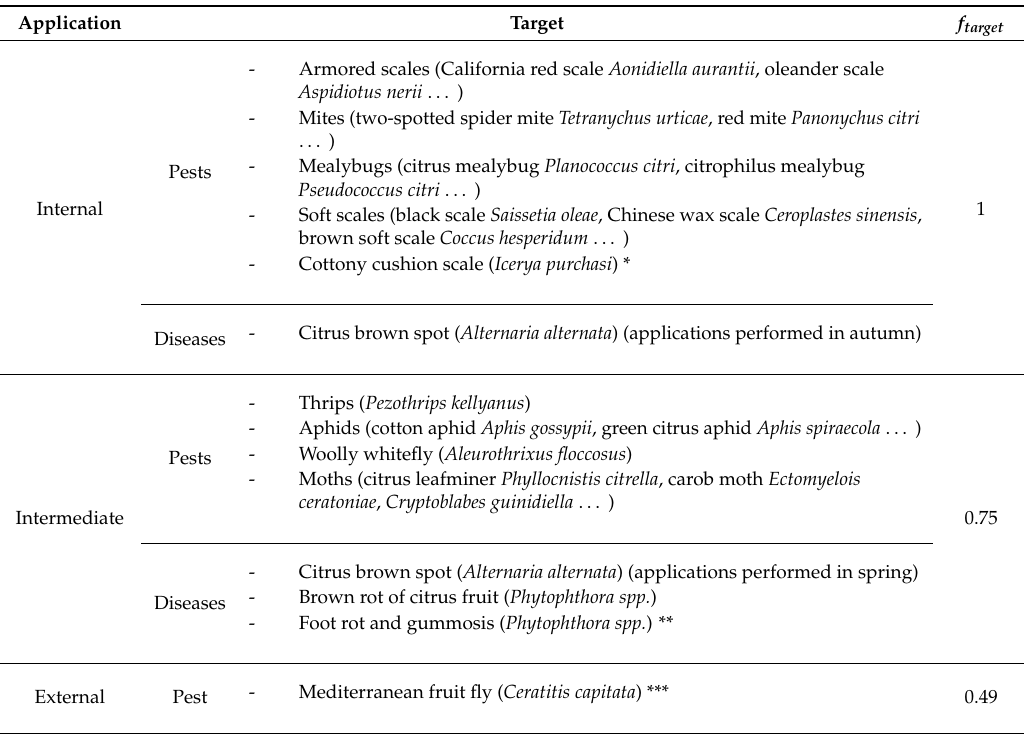
Table 1. Targets allocated with each type of application and the corresponding calculated value of f target